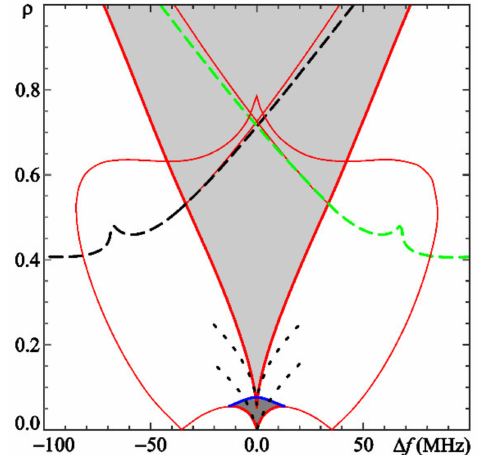
Figure 5. Locking domain on the ∆ f , ρ -plane at µ = 15.0, ∆ H = 0.534, I 0 = 0.05, and ψ = 0.8 π . Boundaries of saddle-node and Andronov–Hopf bifurcations are shown with red and blue lines, respectively. Dashed lines show the stability boundaries of the regimes when one gyrotron suppresses the other. Dotted line shows the locking boundary obtained from the generalized Adler’s equation (Section 3.2). The domains of in-phase and anti-phase locking are shown by dark and light shading,